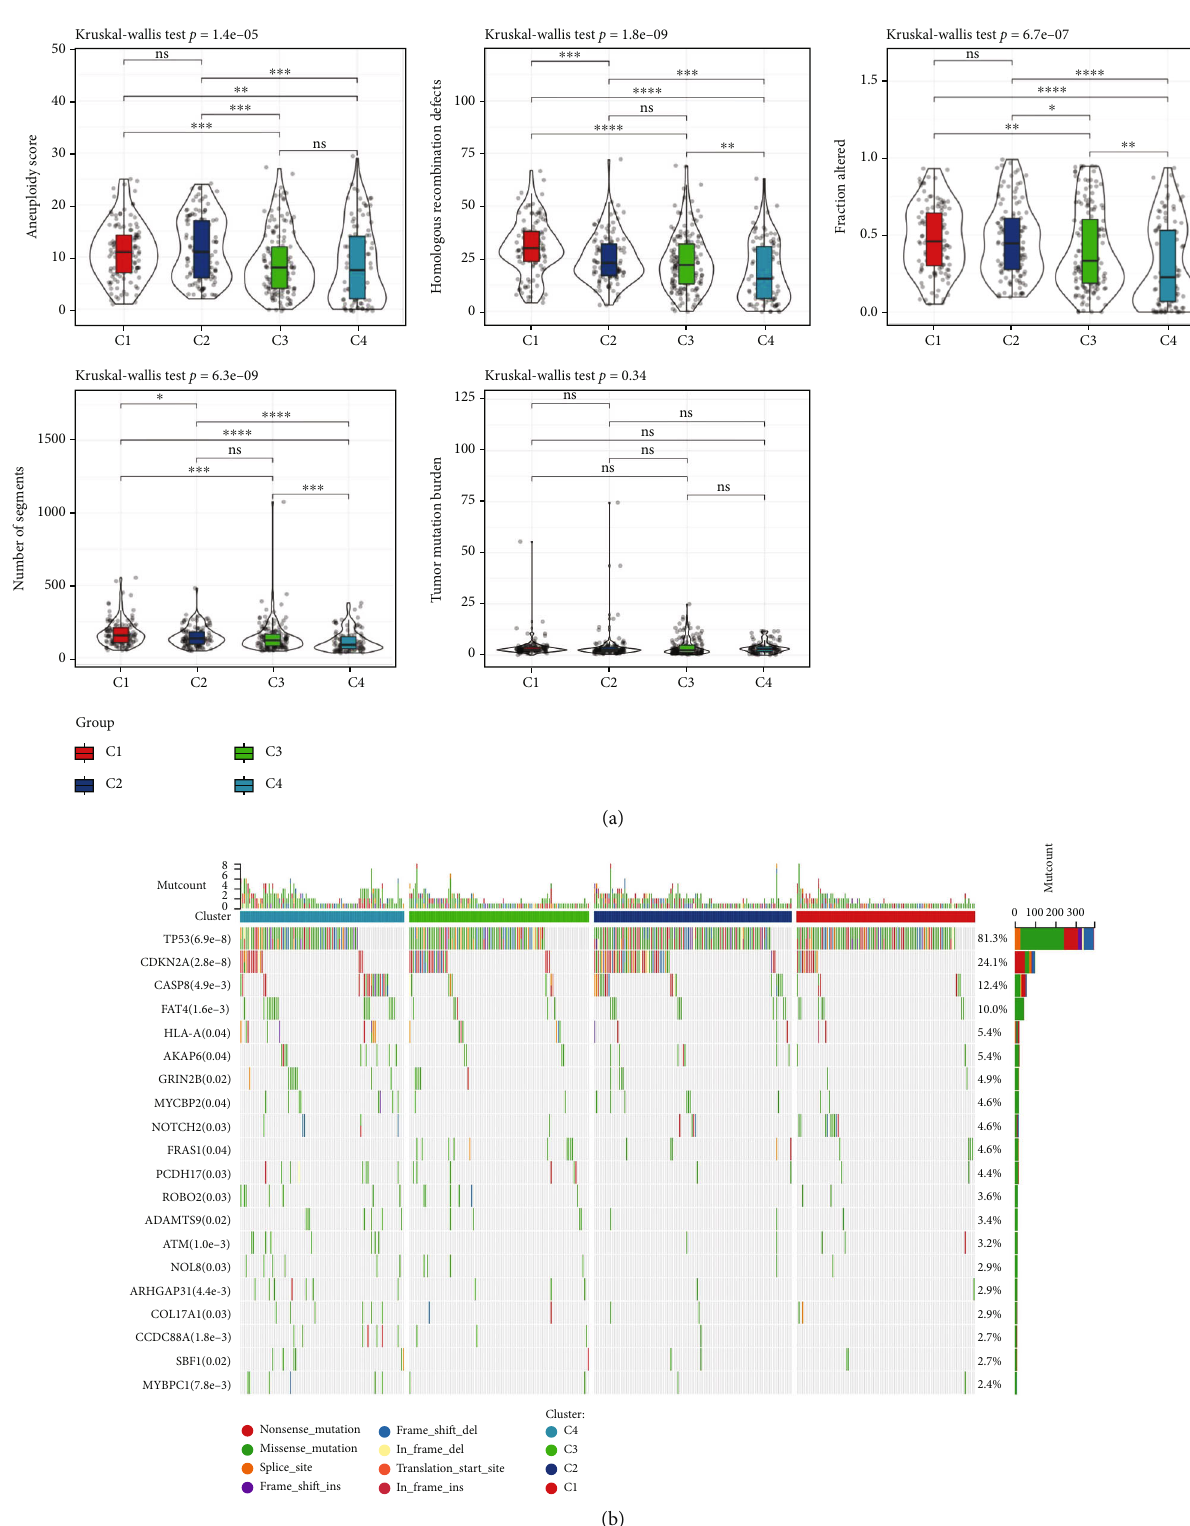
Figure 2: Genomic alterations in the molecular subtypes of the TCGA cohort. (a) Comparison of tumor mutation burden di ff erences, aneuploidy score, homologous recombination defects, number of segments, and fraction altered. (b) Somatic mutations in the four molecular subtypes (chi-square test). ∗ P < 0 : 05 , ∗∗ P < 0 : 01 , ∗∗∗ P < 0 : 001 , and ∗∗∗∗ P < 0 : 0001